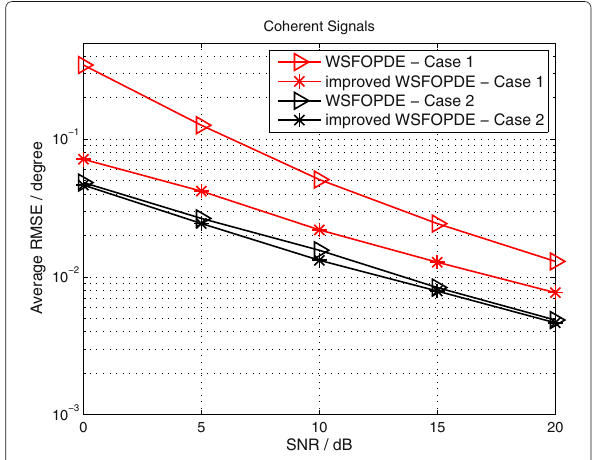
Fig. 8 The RMSE performance variation under different sub-signals